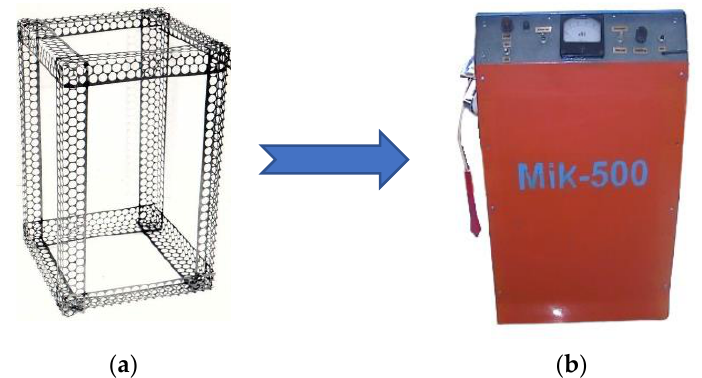
Figure 12. Prismatic frame made of angle-type steel PP ( a ), the device with steel sheet cladding ( b ) [44]. Used materials, as a rule, have surface damage–corrosion areas, non-linearity and other defects (Figure 13).